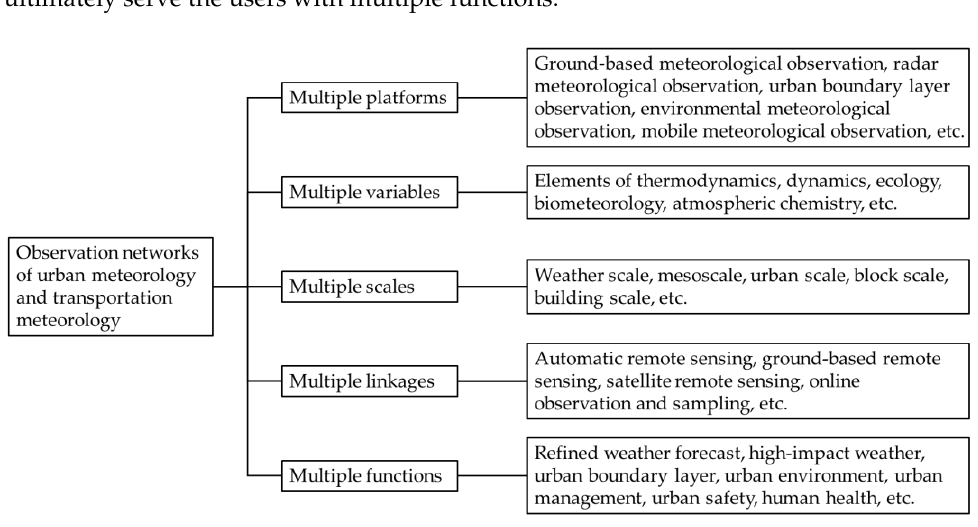
Figure 1. Characteristics and development directions of urban transportation meteorological observation network.